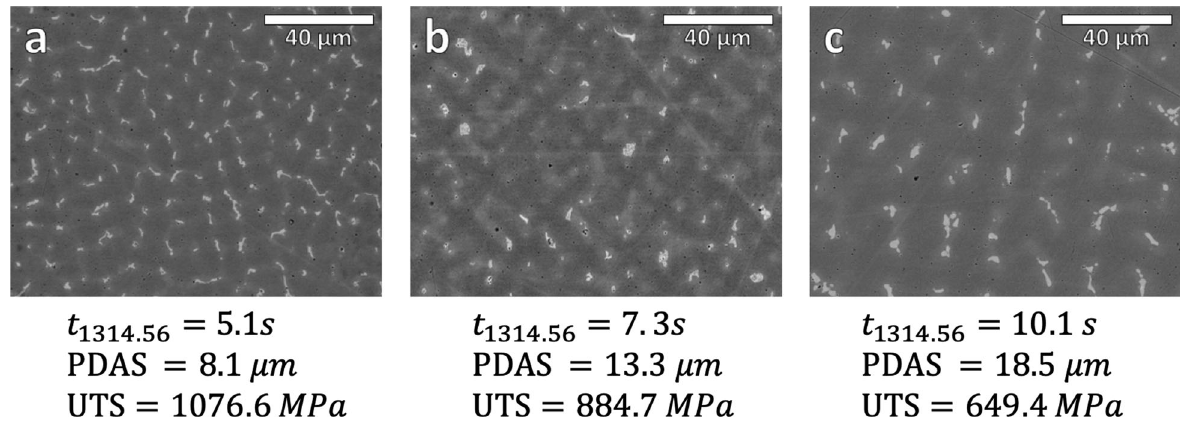
Fig. 9 Dendrite scale microstructure observations using scanning electron microscope (SEM). Three specimens were cut from the similar ROI of different as-built thin walls. The value of t 1314.56 , measured primary dendrite arm spacing (PDAS) and ultimate tensile strength (UTS) are listed at the bottom. a specimen from wall #9:120 mm in length with 5 s dwell time, b specimen from wall #10:120 mm in length without dwell time with melt pool control, c specimen from wall #1:80 mm in length without dwell time. Detailed experimental setup is provided in “ Directed energy deposition ” section. Credit: Jennifer